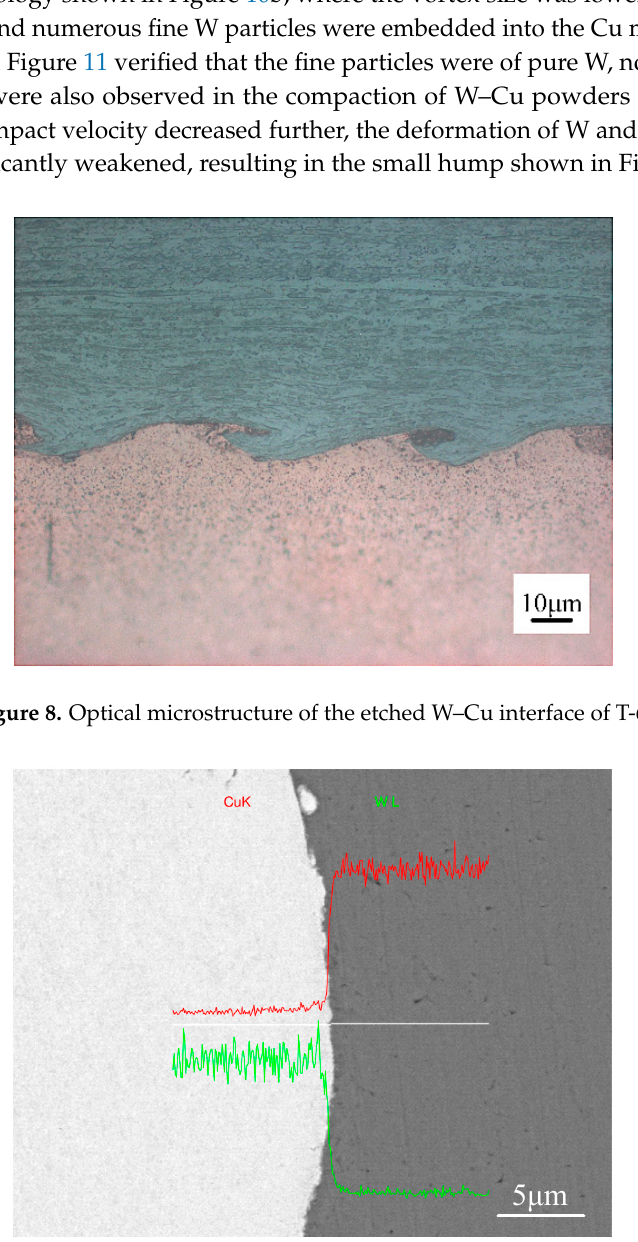
Figure 9. Chemical composition distribution across the W–Cu interface of T-6.